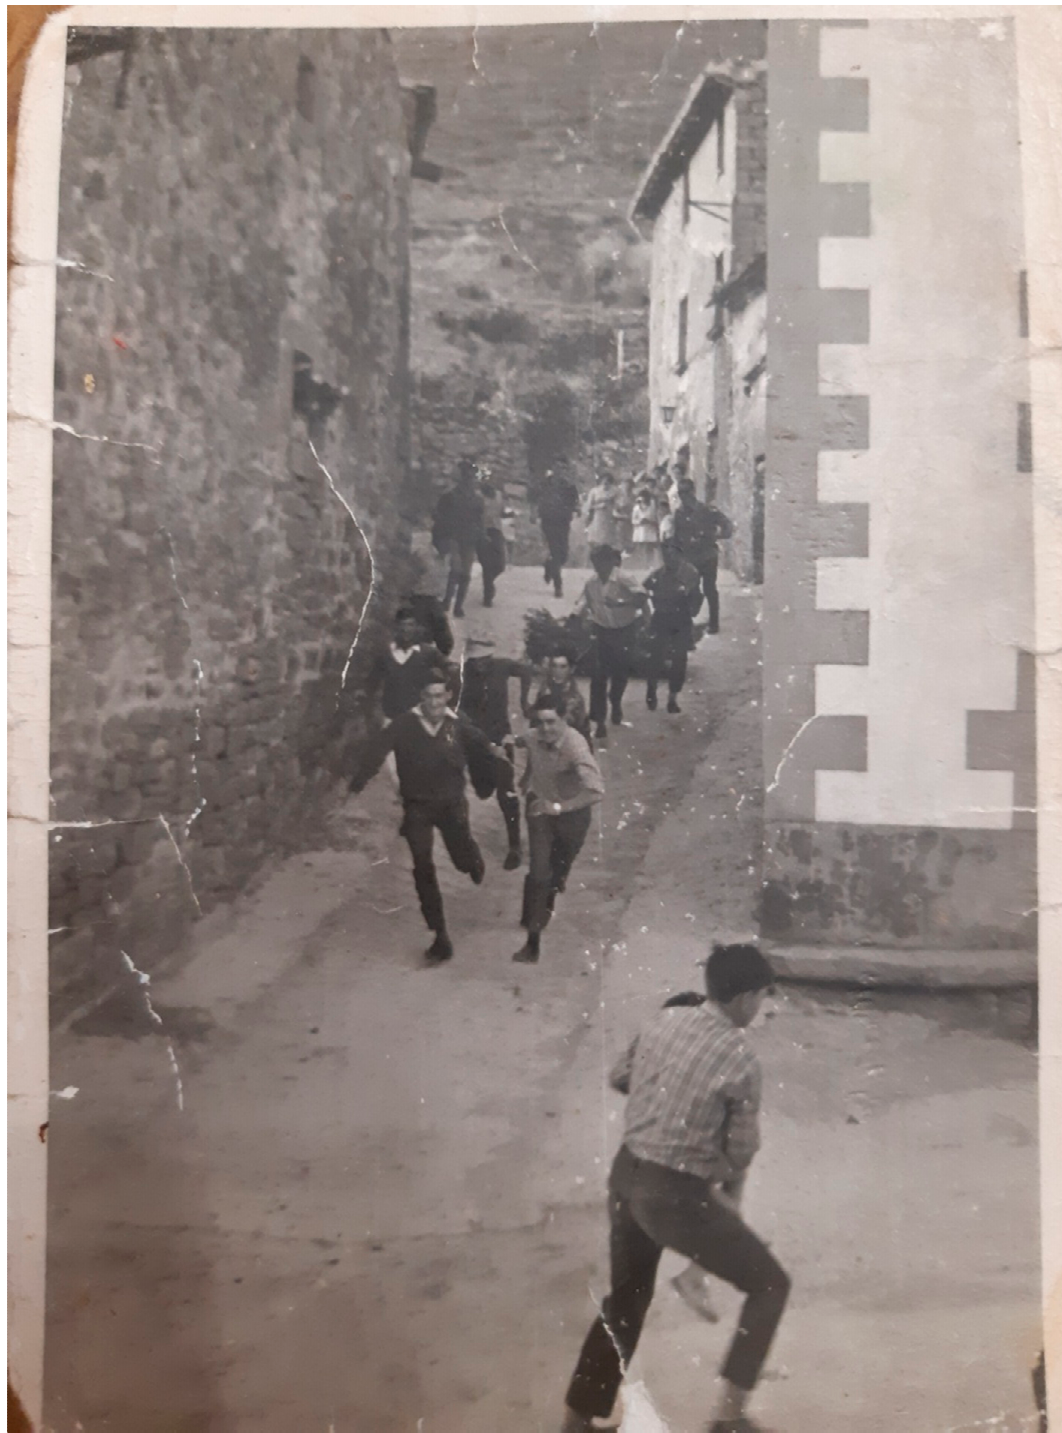
Figure 5. Simulated run in front of bulls. Source: Private Archive of Carmelo San Martin.